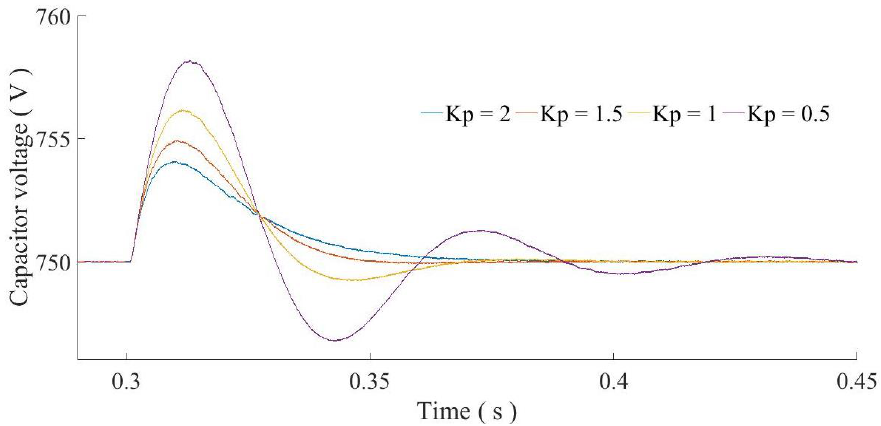
Figure 9. Influence of K p on the dynamic performance of the DDPS.